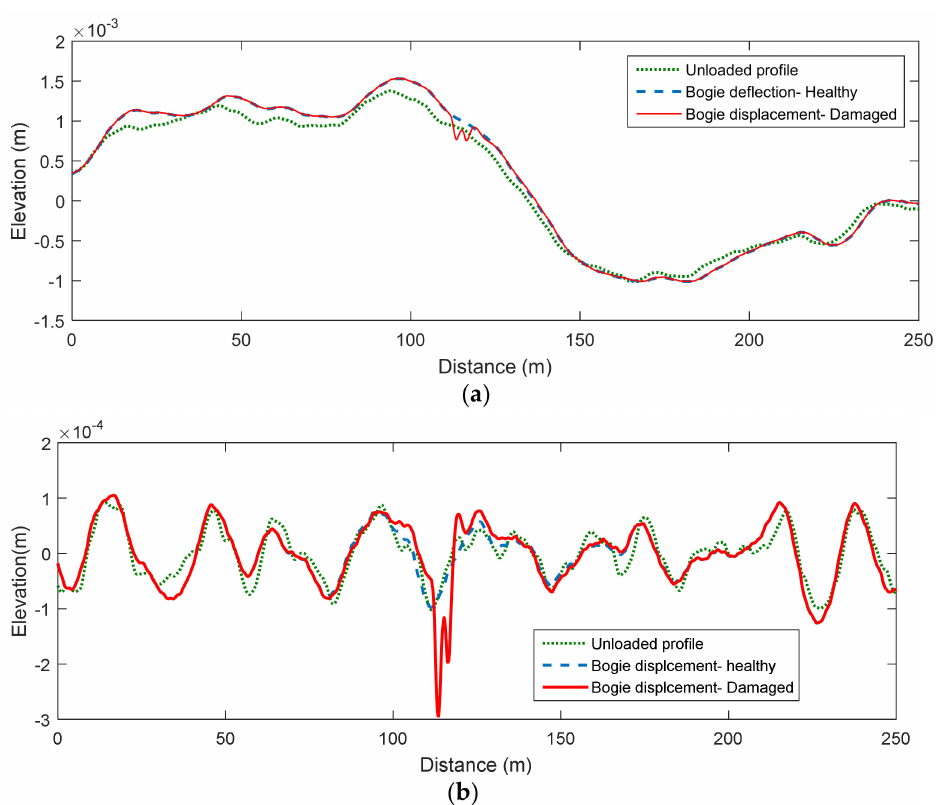
Figure 11. Bogie vertical displacement for the healthy and damaged cases and the unloaded profile, ( a ) unfiltered; ( b ) filtered unloaded